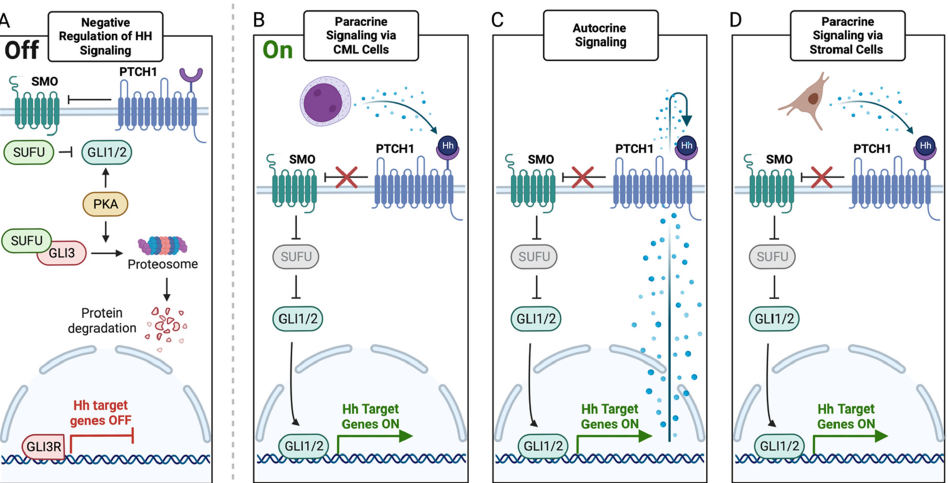
Figure 1. Canonical Mechanisms of Hedgehog Signaling. ( A ) In the absence of HH ligands, PTCH1 inhibits SMO and promotes SUFU-mediated inhibition of GLI1/2 and GLI3 proteolytic degradation to GLIR which translocates to the nucleus as a transcriptional repressor. ( B ) Paracrine, or type III signaling, involves the binding of the HH ligand, which is secreted by cancer cells to the PTCH1 receptor which prevents PTCH-mediated inhibition of SMO, lifting the SUFU-mediated repression of GLI1/2 and promoting the transcription of HH target genes. ( C ) Type II ligand-dependent autocrine/juxtacrine signaling involves the secretion and exportation of HH ligands from the cell which then bind to the cell’s own PTCH1 receptor to trigger the cascade seen in type I